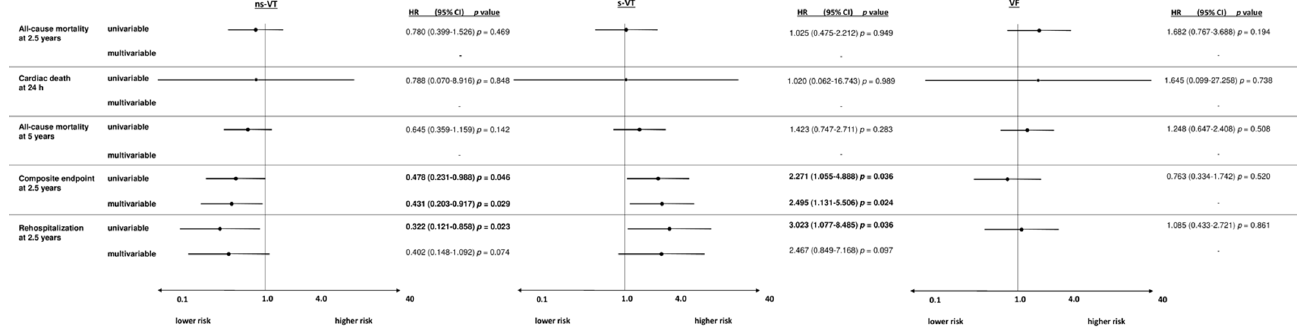
Figure 5. Forest plots demonstrating the uni- and multivariable hazard ratios (HR) with 95% confi- dence intervals (CI) for the primary endpoint all-cause mortality at 2.5 years, as well as for secondary endpoints all-cause mortality at 24 h, all-cause mortality at 5 years, the composite arrhythmic end- point (i.e., recurrent ventricular tachyarrhythmias, appropriate ICD therapies) at 2.5 years and cardiac rehospitalization at 2.5 years in NICM patients. Multivariable models were adjusted for age, sex, diabetes, chronic kidney disease, LVEF < 35% and COPD. HRs with corresponding 95% CI were calculated for the comparisons of patients with VF compared to s-VT, s-VT versus ns-VT and ns-VT versus s-VT and VF.